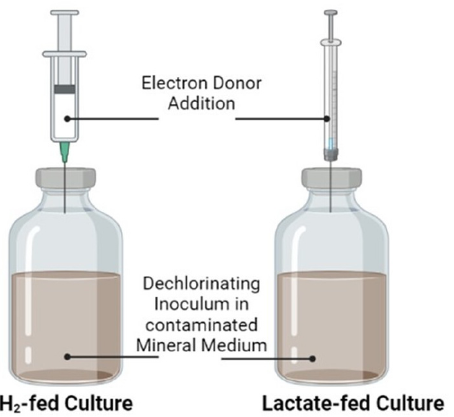
Figure 1. The schematic draw of the batch reactors under different electron donor feeding conditions.